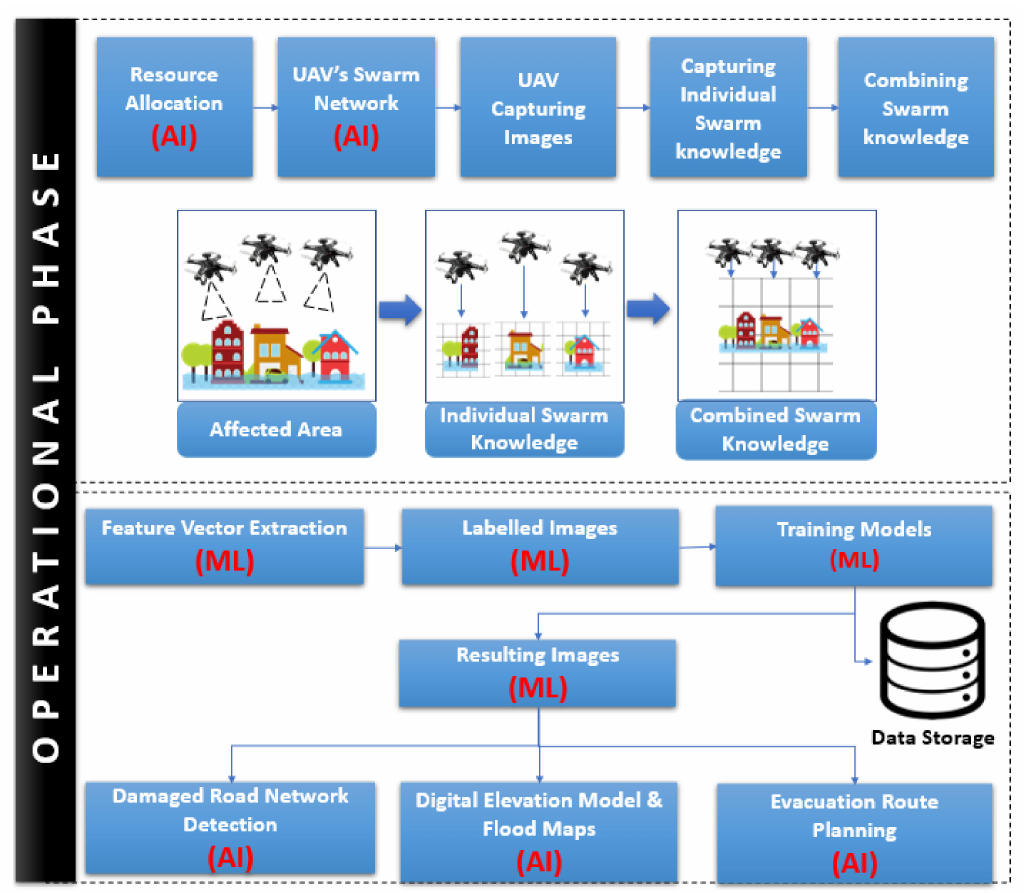
Figure 8. Proposed strategy for flood risk